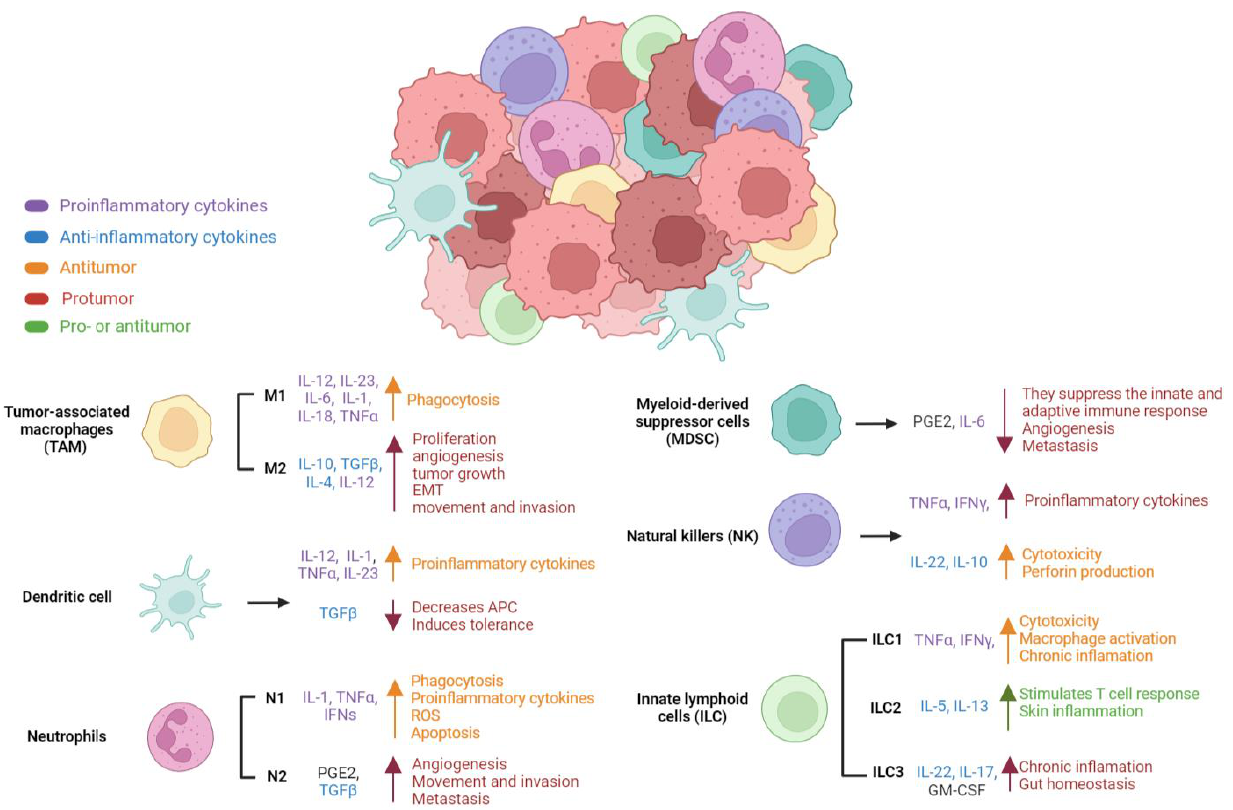
Figure 1. Cells of the immune system are present in the tumor microenvironment. Each cell se- cretes different cytokines, which can have a pro-tumorigenic, antitumorigenic, or both [11,13,20].